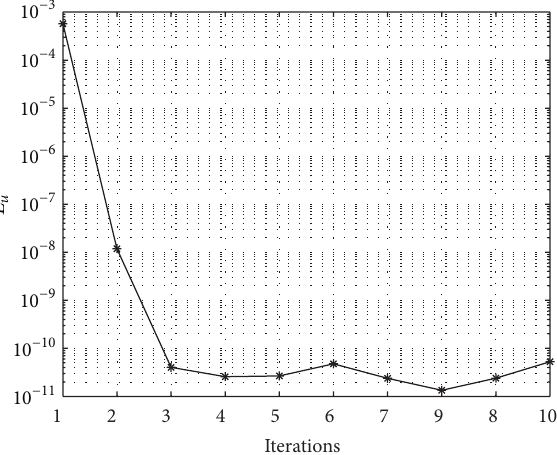
Figure 18: Modified KdV equation convergence